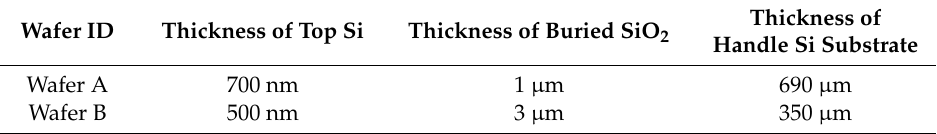
Table 1. Parameters of the used SOI wafers.